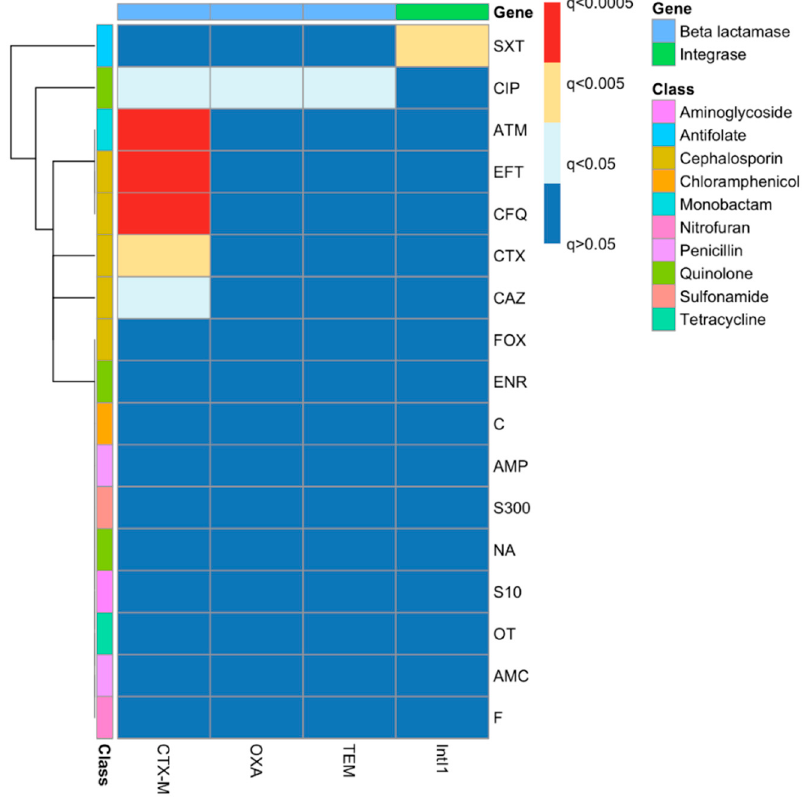
Figure 4. Associations between resistance genes and phenotypes as identified by chi-squared tests with false discovery rate corrections. The left side of the figure represents the different antibiotic resistance phenotypes that belong to different antibiotic classes, as clarified in the colour key, while the top of the figure represents the different genes that were tested.